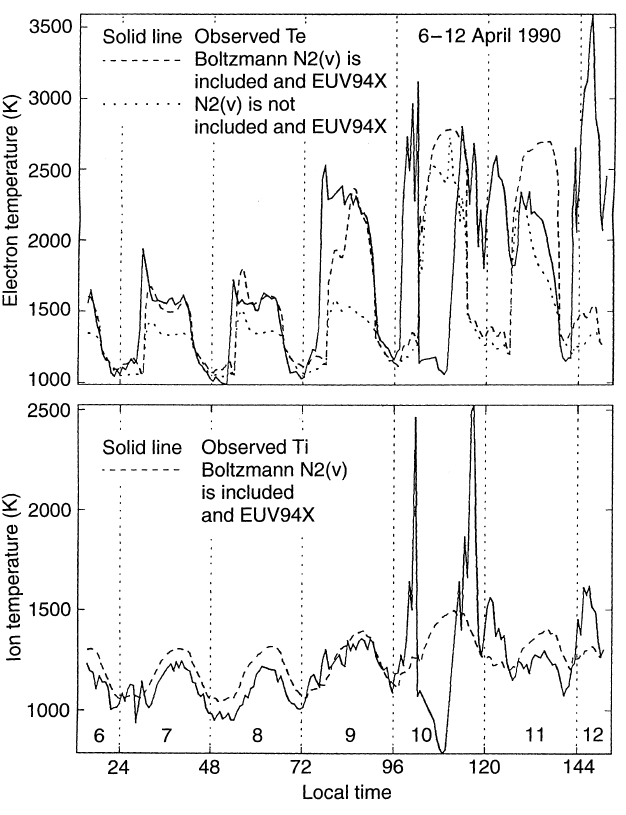
Fig. 8. The measured ( solid lines ) and modeled ( dashed and dotted lines ) electron ( top ) and ion ( bottom ) temperatures at the F2 peak altitude 6–12 April 1990 for the EUV94X solar flux model. The dashed lines show results when the Boltzmann populations of the first five vibrational levels of N 2 ( v ) are included in the model and the dotted line is one without effects of vibrationally excited N 2 on the loss rate of the O (cid:135) (cid:133) 4 S (cid:134)